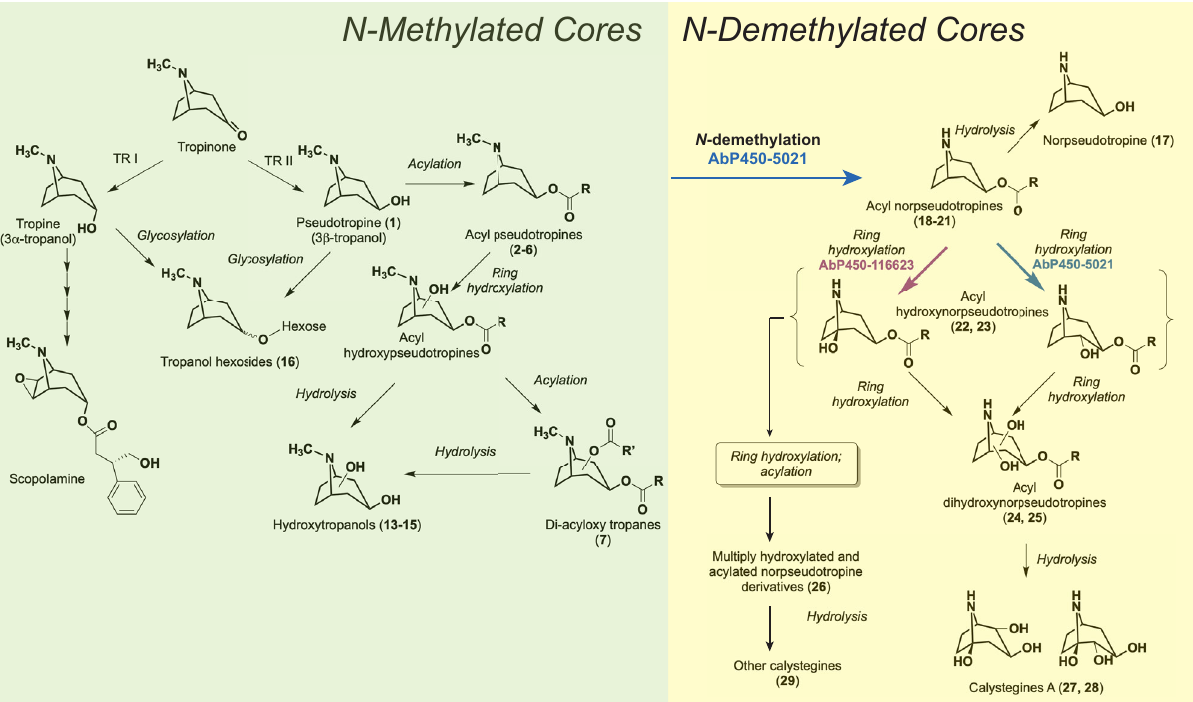
Fig. 5 Model for the pseudotropine-dependent biosynthesis of modi fi ed tropane alkaloids in A. belladonna root and the roles of AbP450-5021 and AbP450-116623. The depicted alkaloid sub-network model is based on our fi ndings from discovery metabolite pro fi ling in A. belladonna VIGS and control lines, transient assays in N. benthamiana , and NMR experiments. Note annotated metabolites supporting this model are indicated by numbers (Supplementary Data 1, Fig. 2). Pseudotropine is converted to acyl pseudotropines that are channeled into the production of acylated and non-acylated modi fi ed tropane alkaloids with N -methylated and N -demethylated cores. The biosynthesis of N -demethylated alkaloids with norpseudotropine cores depends on the activity of the N -demethylase/ring-hydroxylase AbP450-5021. This enzyme catalyzes the N -demethylation of acyl pseudotropines to acyl norpseudotropines. Norpseudotropine is likely formed through hydrolysis of acyl norpseudotropines. Both AbP450-116623 (ring-hydroxylase) and AbP450-5021 ( N -demethylase/ring-hydroxylase) catalyze the subsequent conversion of acyl norpseudotropines to respective acyl hydroxynorpseudotropines. Note that acyl norpseudotropines are meso compounds each with a mirror plane of symmetry. Thus, positions 1 and 5 (carbon atoms adjacent to the ring-nitrogen) are equivalent as are the positions 2 and 4 (carbon atoms adjacent to the esteri fi ed carbon atom), yielding the potential to form, for example, acyl hydroxynorpseudotropine enantiomers that are hydroxylated in either position 1 or 5. Acyl hydroxynorpseudotropines are subject to further modi fi cations, and the resulting metabolites are likely metabolized to non-acylated